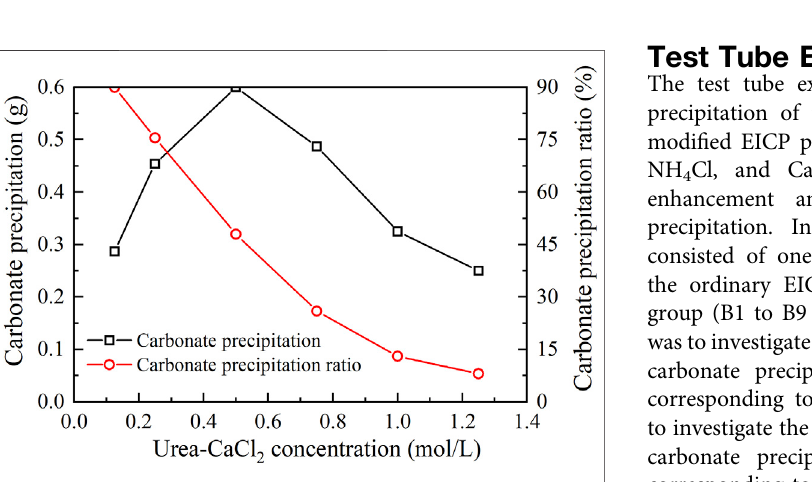
FIGURE 3 | Relations of the actual mass of carbonate precipitation and theprecipitationratio(PR)versustheurea – CaCl 2 concentrationintheordinary EICP